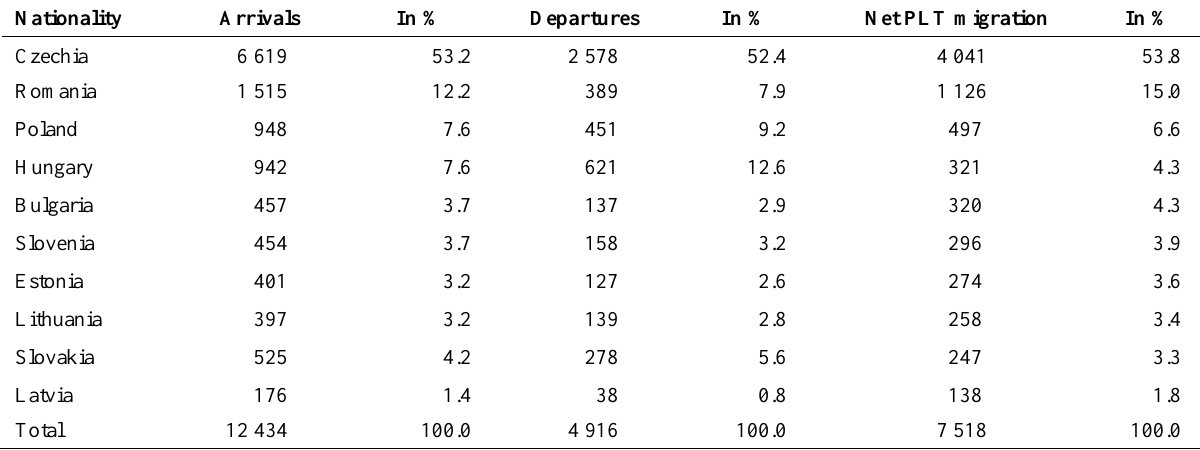
Table 2. PLT arrivals, departures and net PLT migration of the CEE countries’ nationals to New Zea- land,